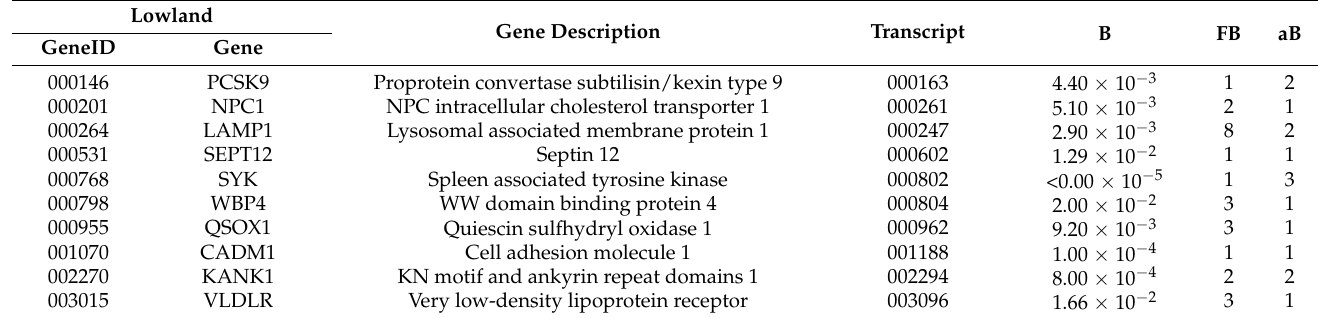
Table 5. Summary of the positive selection analysis for candidate genes of lineages of dicroglossid frogs and toad-headed agamas [7] identified across an elevational gradient, tested likewise positive in Asymblepharus (A) using BUSTED (B); p -value > 0.05) [55], FUBAR (FB; number of sites under positive selection) [56] and aBSREL (aB, number of branches with positive selection) [57,58] methods. Ensembl gene and transcript identifier (ENSACAG00000, ENSACAT00000) refers to Anolis carolinensis